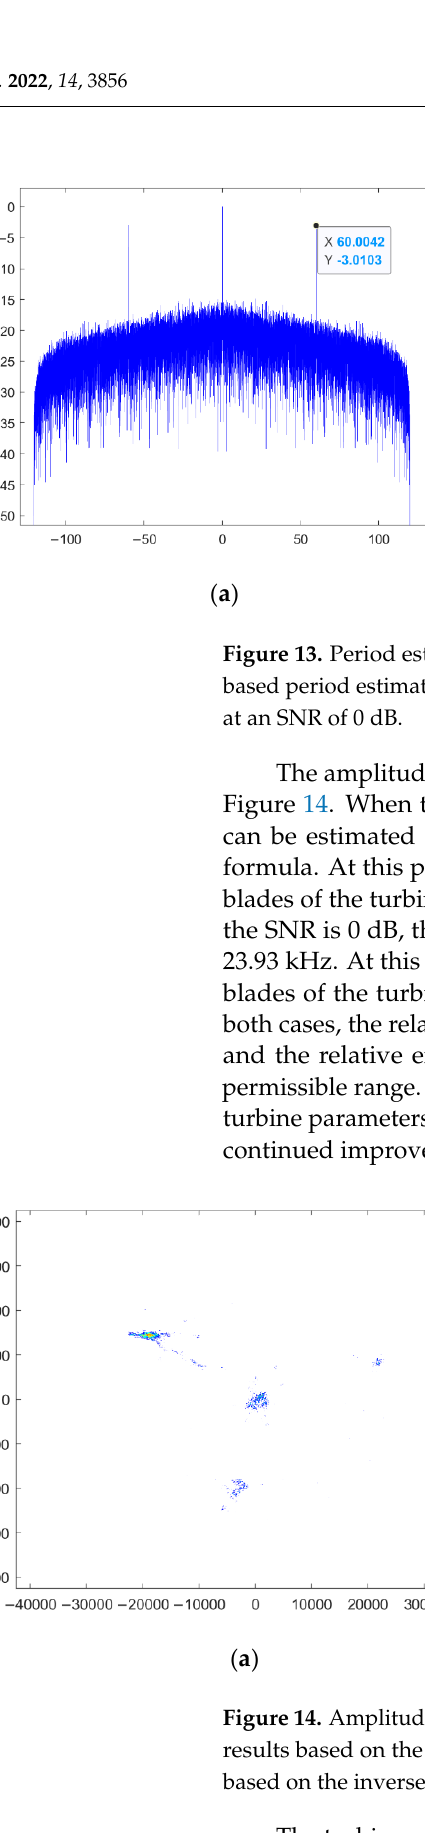
Figure 13. Period estimation results are based on autocorrelation: ( a ) The result of autocorrelation- based period estimation at an SNR of 5 dB. ( b ) The result of autocorrelation-based period estimation at an SNR of 0 dB.